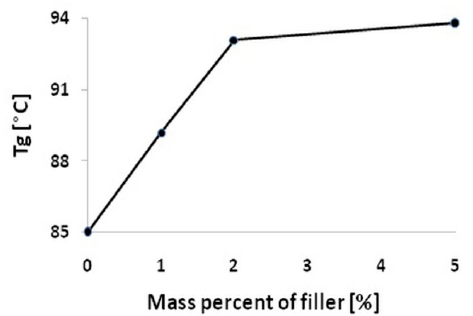
Figure 6. Glass transformation temperature of the composites epoxy / APTS functionalized hemp fibers as a function of composition.